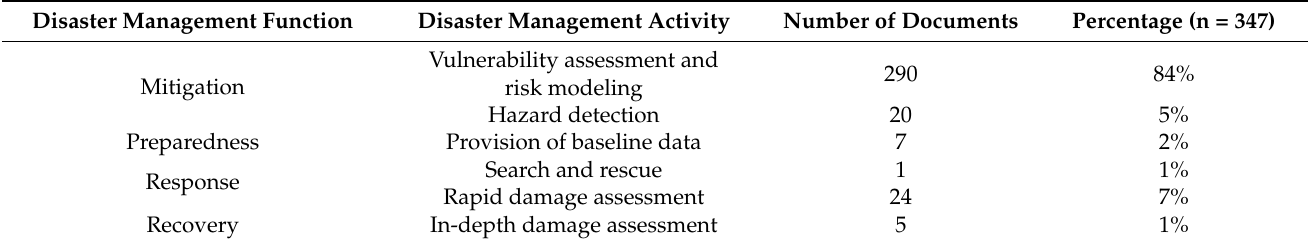
Table 3. Disaster management function and activity.